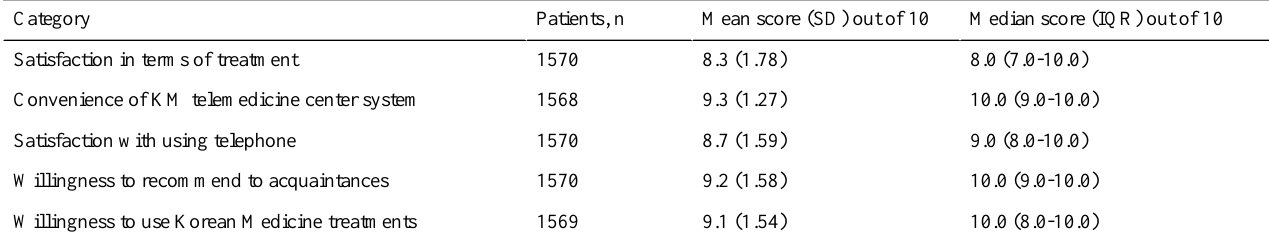
Table 4. Patient satisfaction with Korean Medicine telemedicine program for COVID-19.